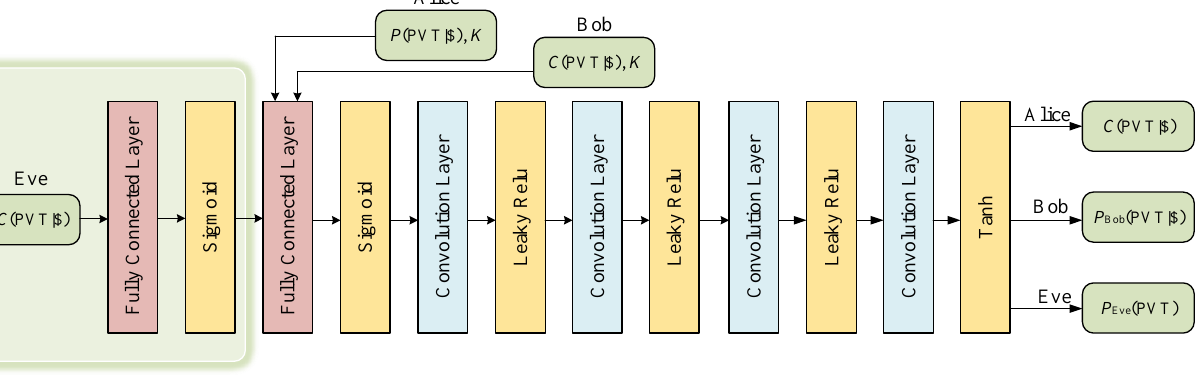
Figure 4. Alice, Bob, and Eve convolutional-neural-network structure. Step 1: Alice and Bob have the same network structure, consisting of a fully connected layer with sigmoid as the activation function, and three convolutional layers with leaky ReLU (rectified linear unit). The output uses the tanh activation-function to normalize the value to ( − 1, 1 )